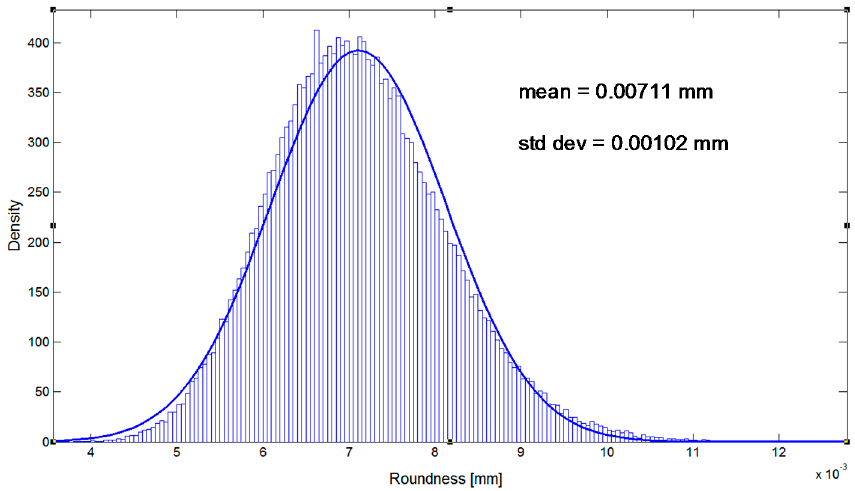
Figure 9. Uncertainty estimation by Monte Carlo method of Case 5.